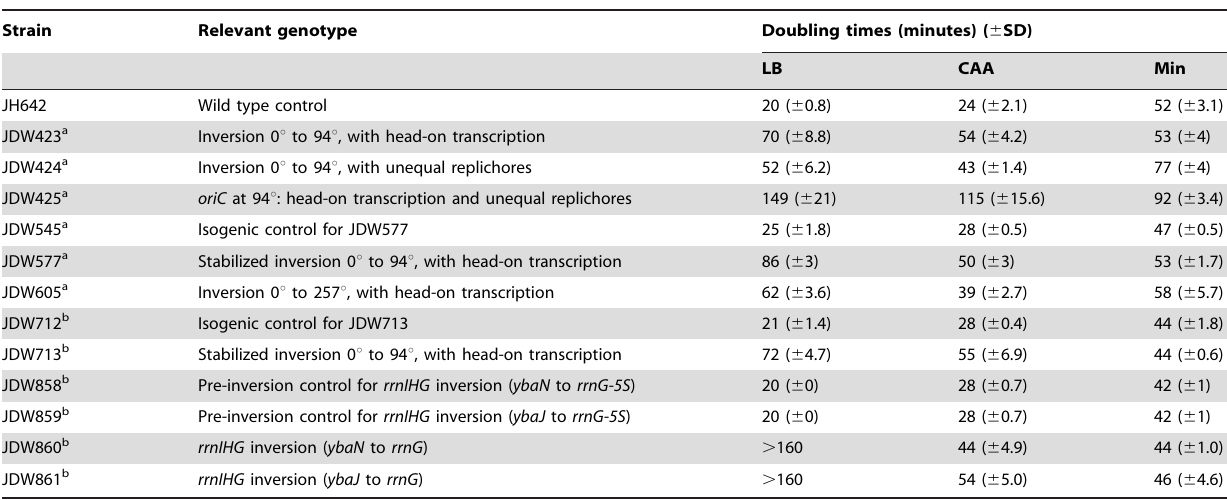
Table 4. Doubling times at 37 u